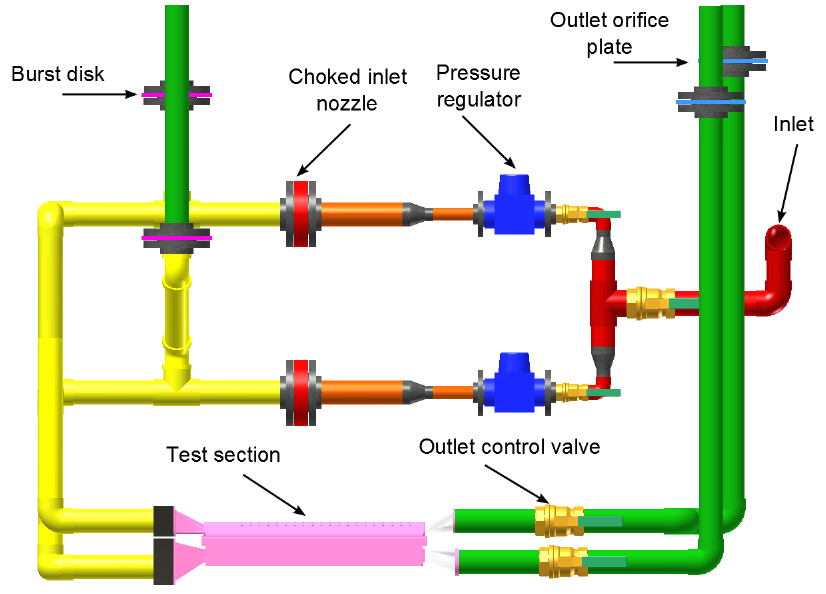
Figure 2. Schematic of experimental